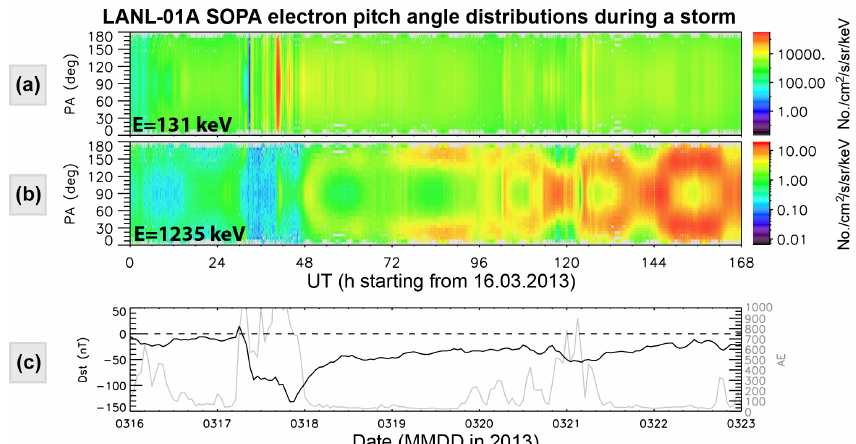
Figure 9. Electron PADs – based upon the derived magnetic field directions – observed by LANL-01A SOPA during a geomagnetic storm period (7 days). (a) Pitch-angle-resolved fluxes for low-energy (131keV) electrons evolve with time. (b) Pitch-angle-resolved fluxes for high-energy (1.2MeV) electrons evolve with time. (c) Dst (black) and Auroral Electrojet (AE) (gray) indices for the period. The time bin size for each PAD is 4min. LANL-01A reaches the noon local time position at ∼ 23:00UT each day during this